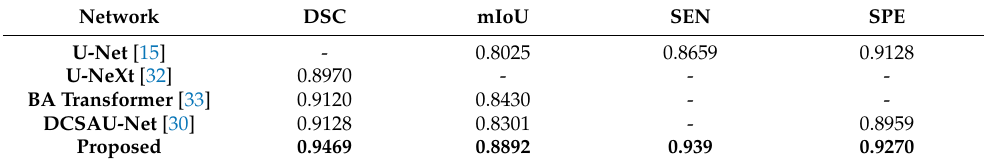
Table 3. Comparison of results of different network architectures on ISIC 2018 Task1 dataset.